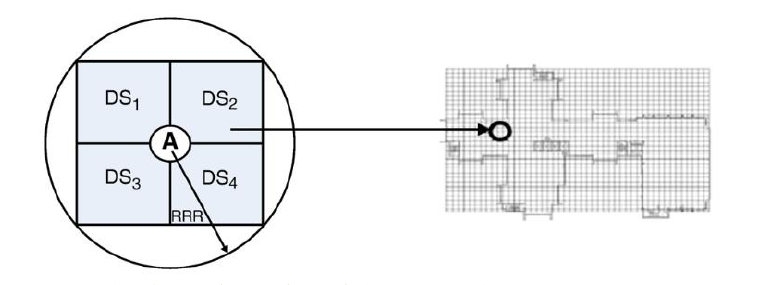
Fig. 6. Reader node and the squares it covers